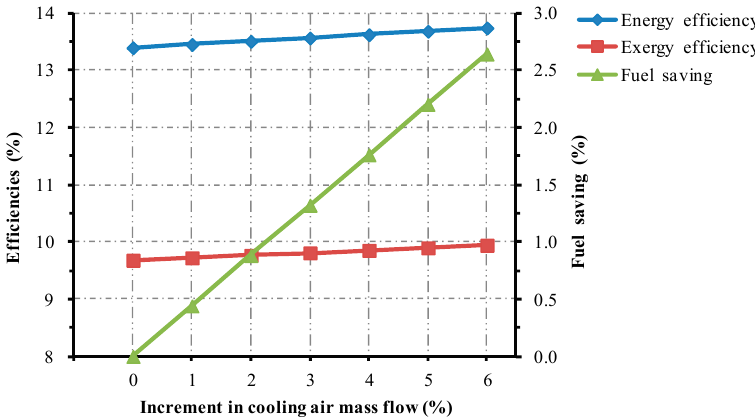
Figure 8. Impacts on energy and exergy efficiencies and fuel-saving of the roller kiln with changes in cooling air mass flow.